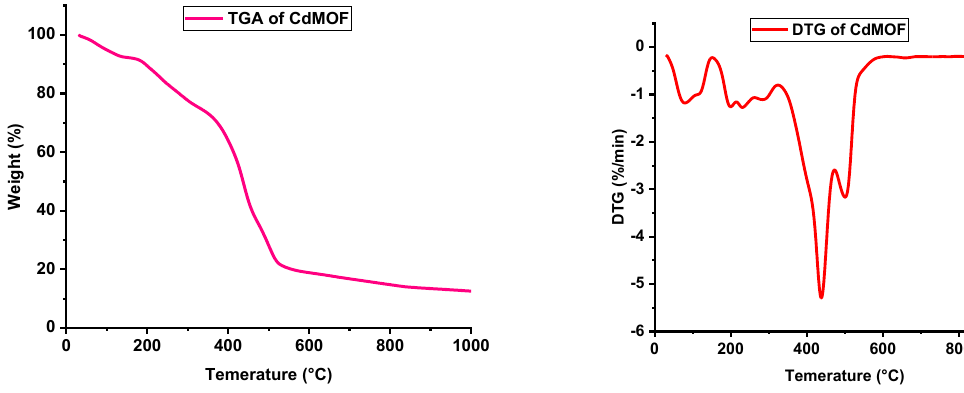
Figure 12. TGA and DTG analysis of CdMOF.